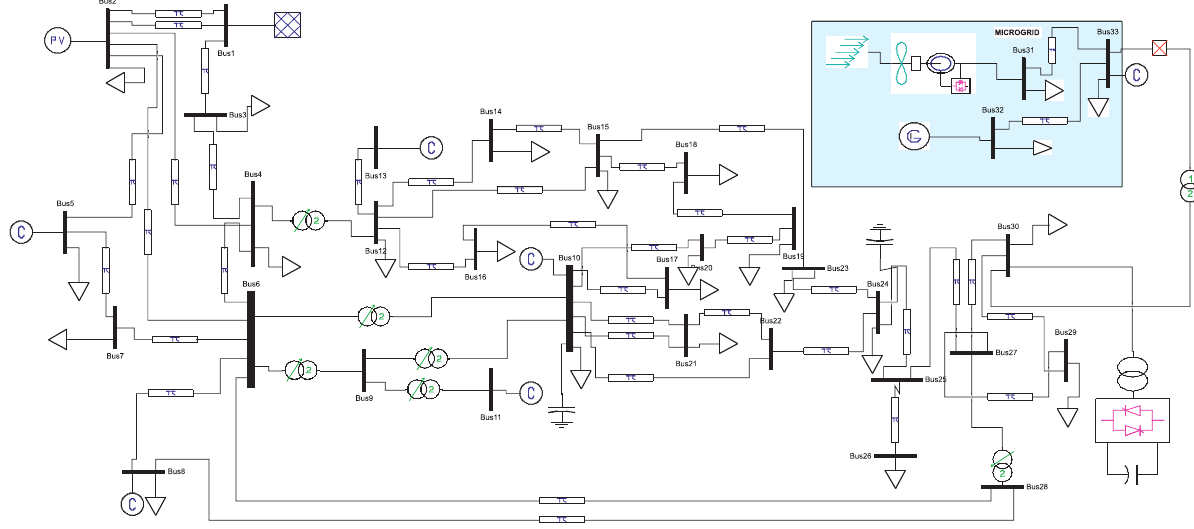
Figure 10: Base case with microgrid and STATCOM controller.